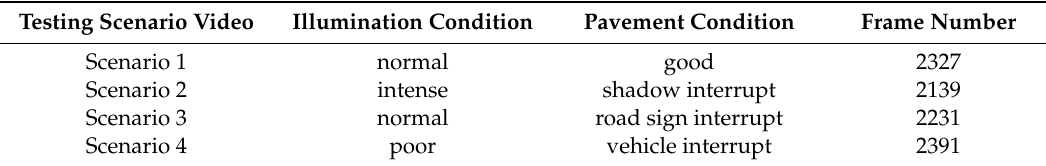
Table 3. Di ff erent testing video scenarios.